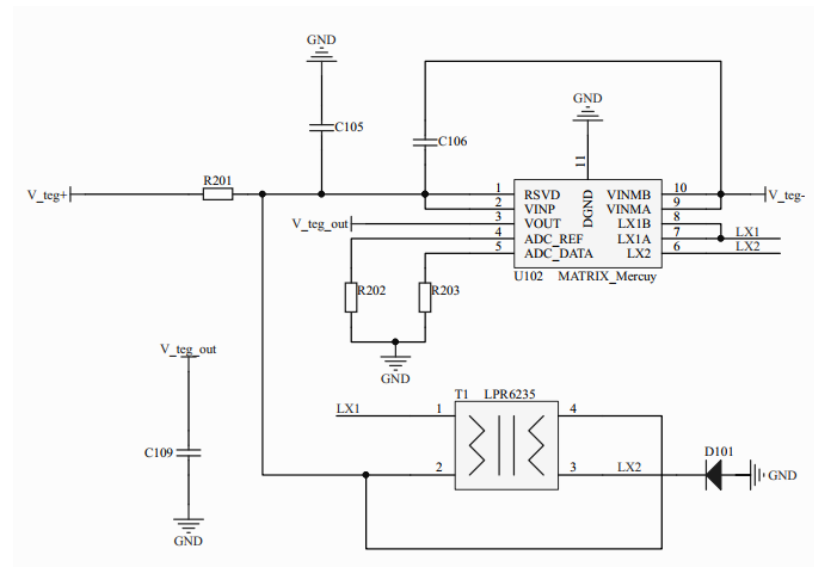
Figure 3. Scheme of the thermal energy-harvesting circuit.